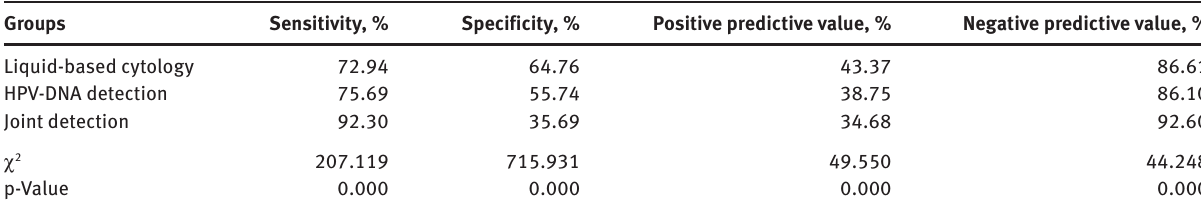
Table 3: Detection efficiency of liquid-based cytology and HPV-DNA in the age group greater than or equal to 50 years. Groups